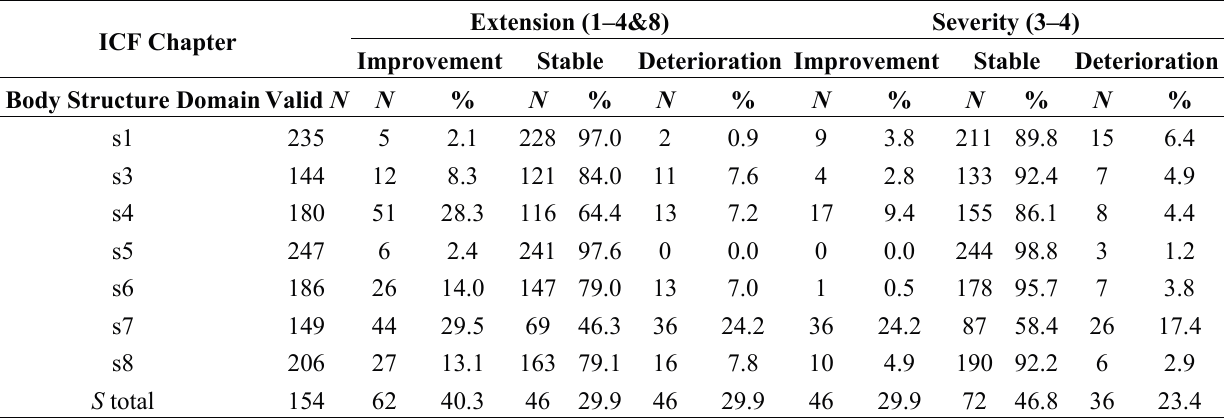
Table 3. Number and percentage of patients who improved, remained stable, or deteriorated with respect to the number of problems of any severity (extension index) or severe or complete problems (severity index) on the various chapters within the Body Structures domain.